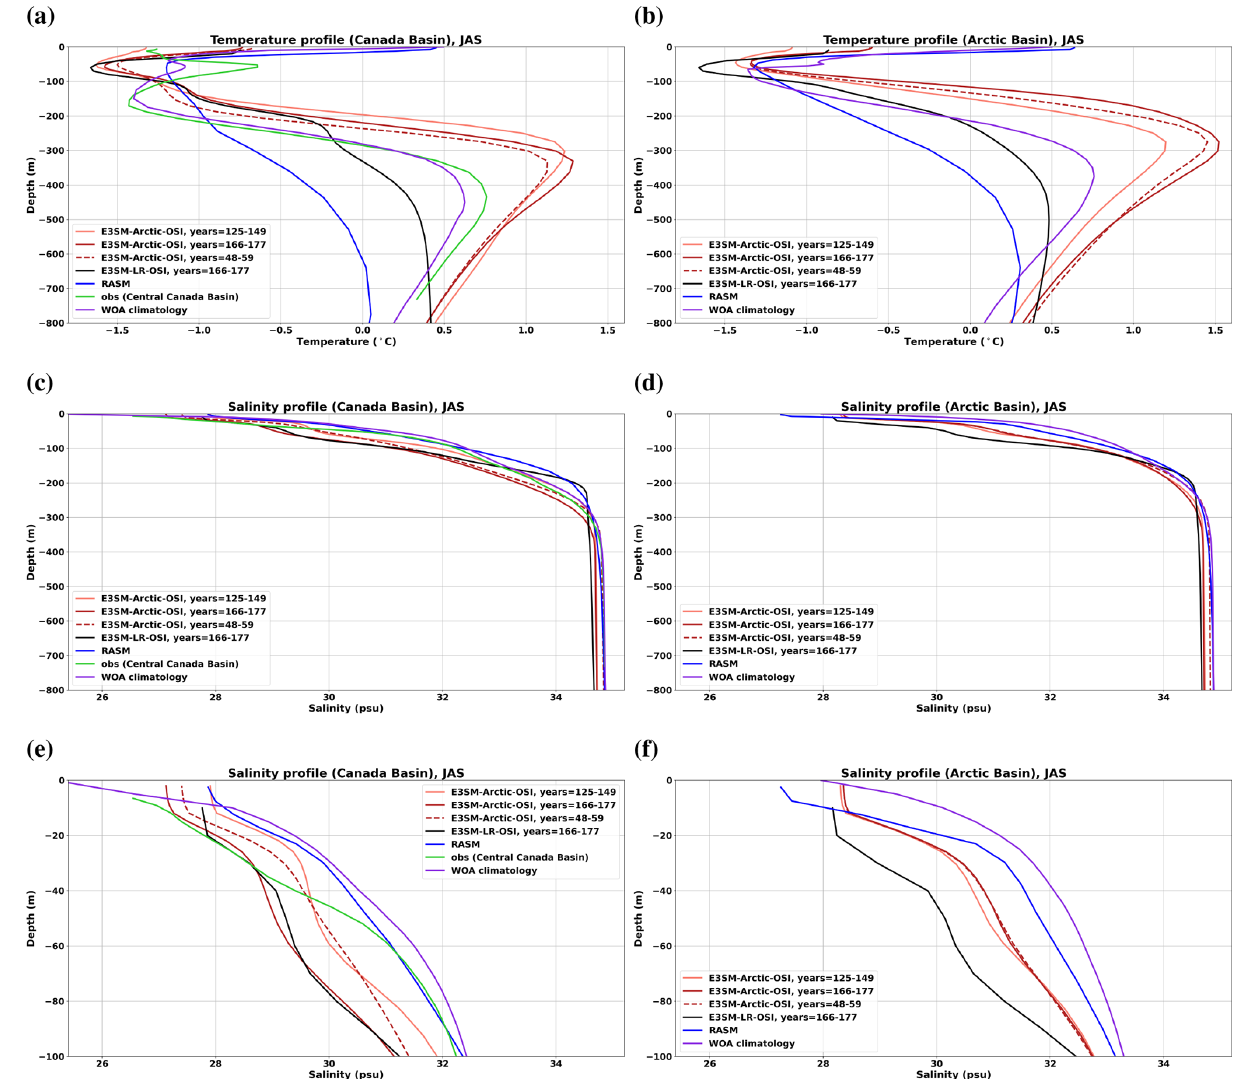
Figure 15. Same as Fig. 14 but for the JAS seasonal